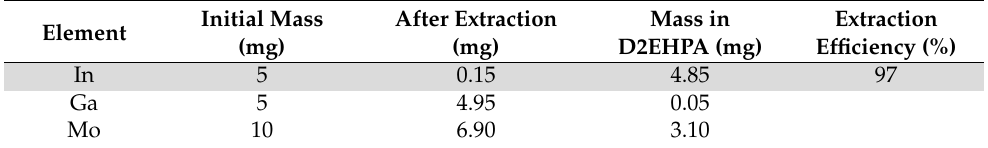
Table 3. Solvent extraction results for indium.